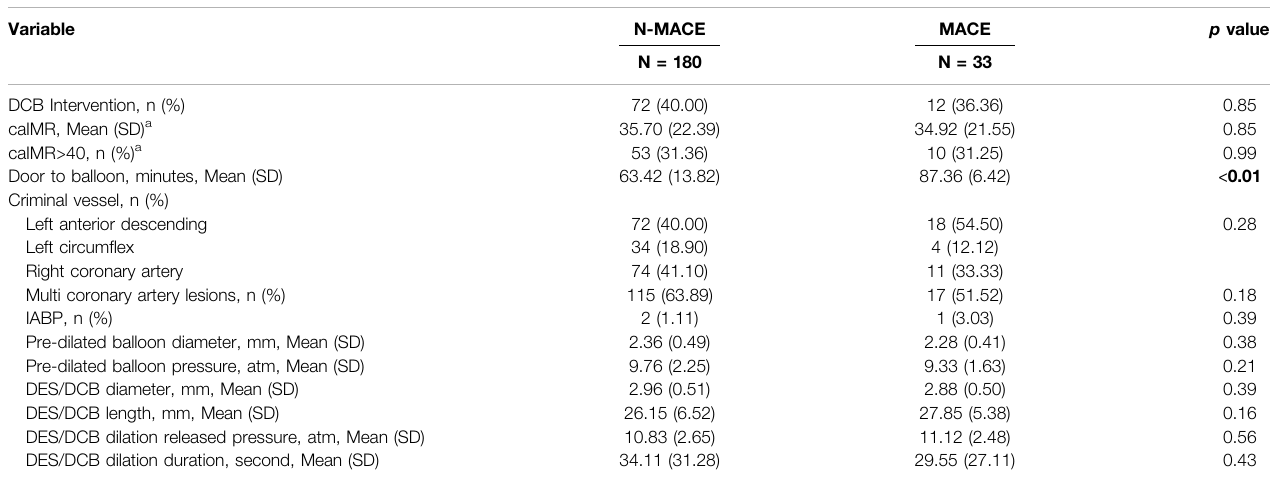
TABLE 4 | Characteristics of PPCI process of the study population grouped by MACEs. Variable